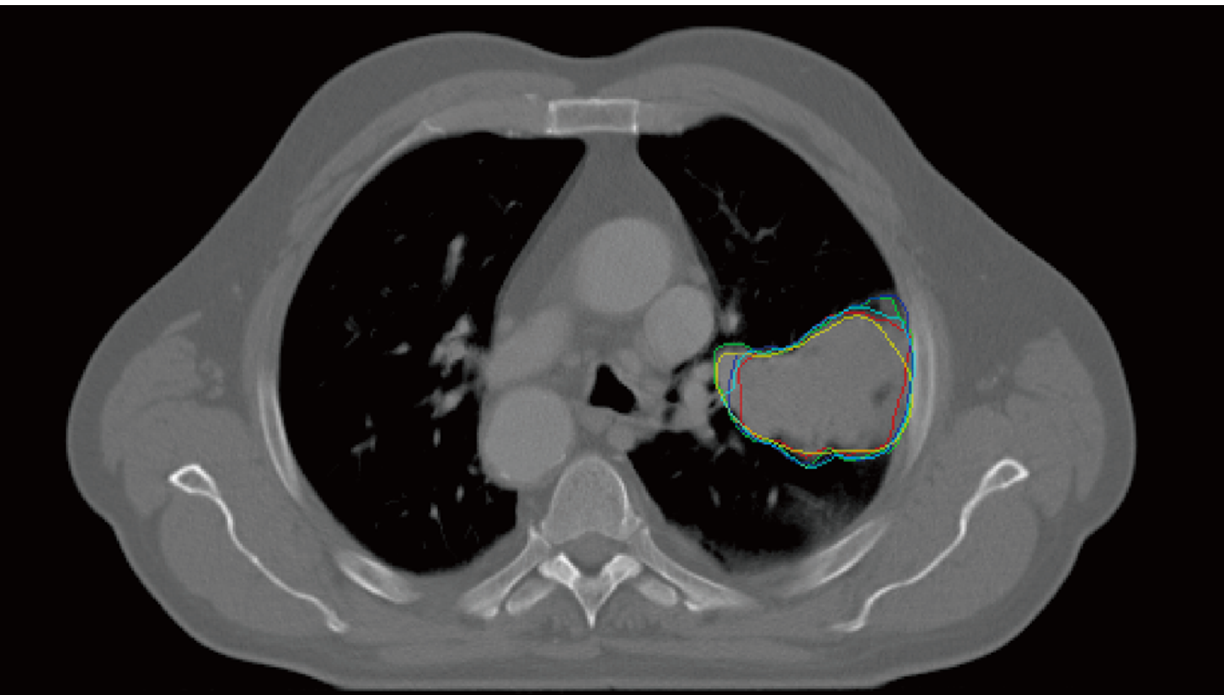
Figure 1. A computed tomography slice and the corresponding primary gross tumor volumes (colored solid lines) independently delineated by five radiation oncologists.